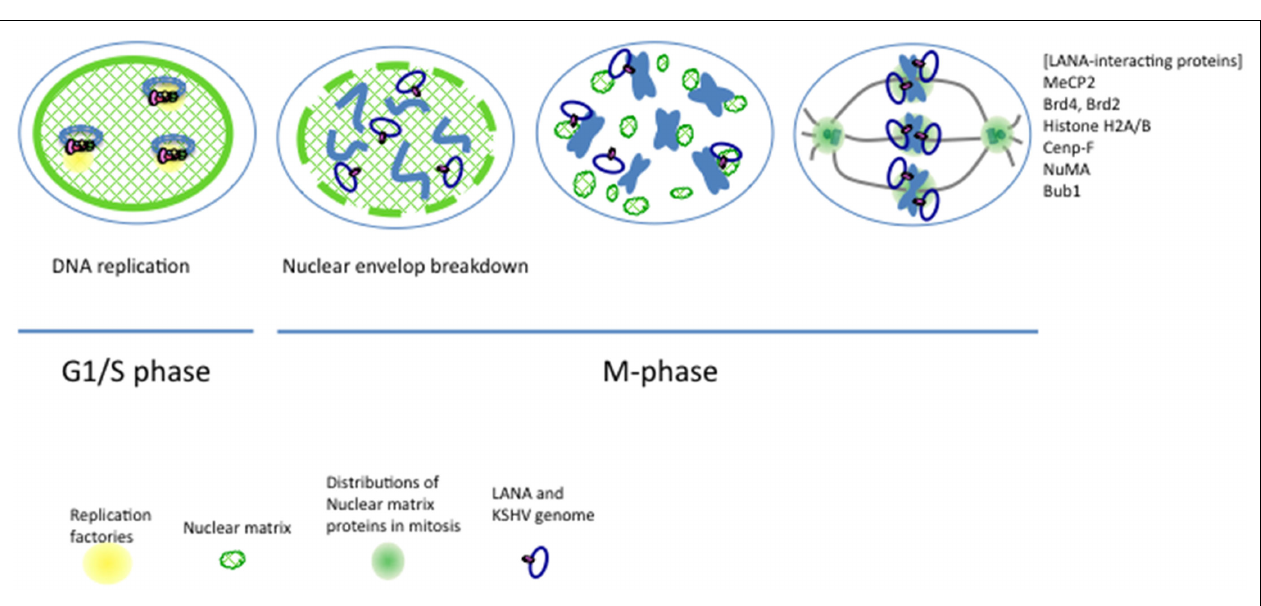
FIGURE 4 |A model for KSHV genome segregation. The KSHV genome associates with the nuclear matrix through LANA, which exhibits nuclear matrix localization activity. DNA replication factories are supposed to anchor to the nuclear matrix, and DNA replication of the KSHV genome occurs on the nuclear matrix at the G1/S phase. Nuclear architectures, including the nuclear matrix, are disrupted at the prophase (nuclear envelope breakdown), and